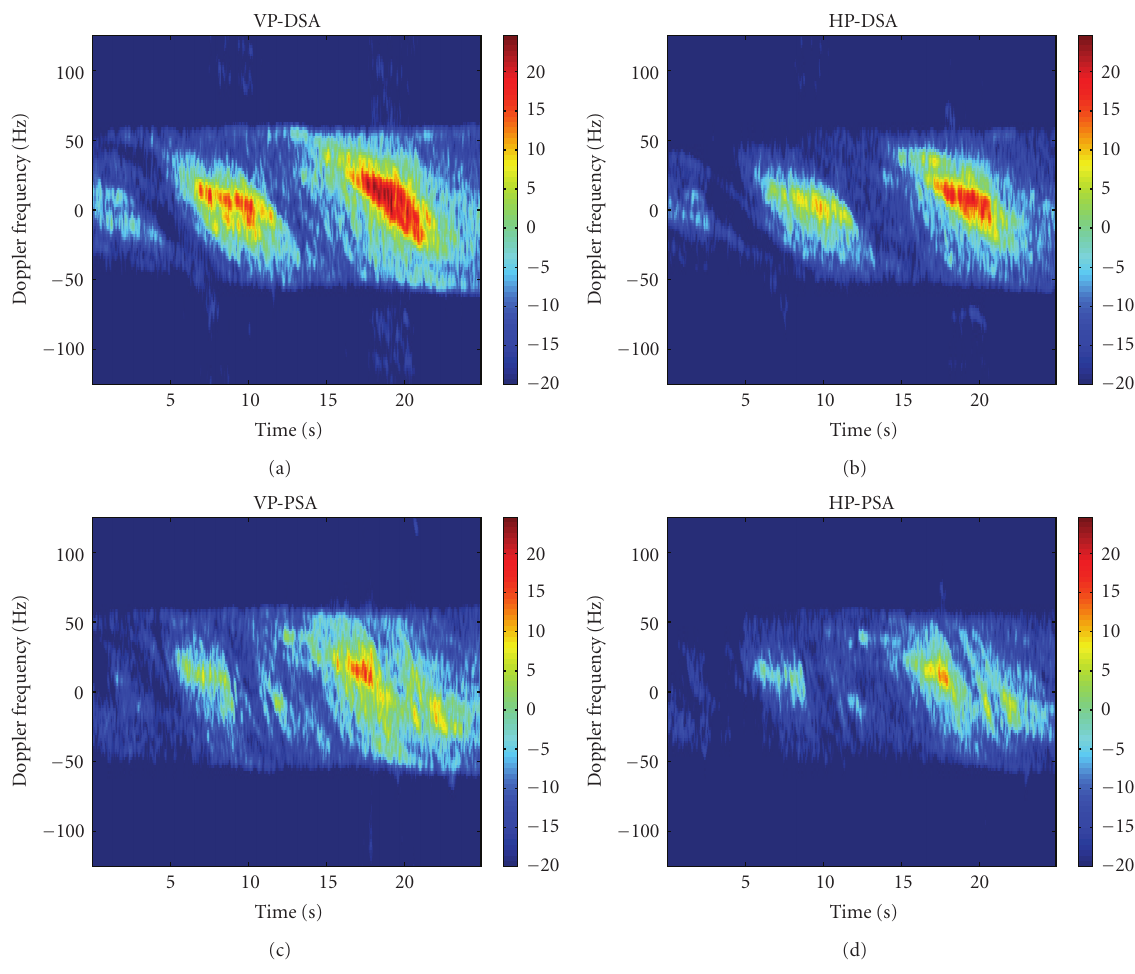
Figure 7: Doppler power (dB) spectra measured at the VP-DSA, HP-DSA, VP-PSA, and HP-PSA on Kent Street. reflection from the vertical walls. In contrast, the secondary signal component arriving from the alley is depolarized with nearly equal signal energy on both polarizations of the